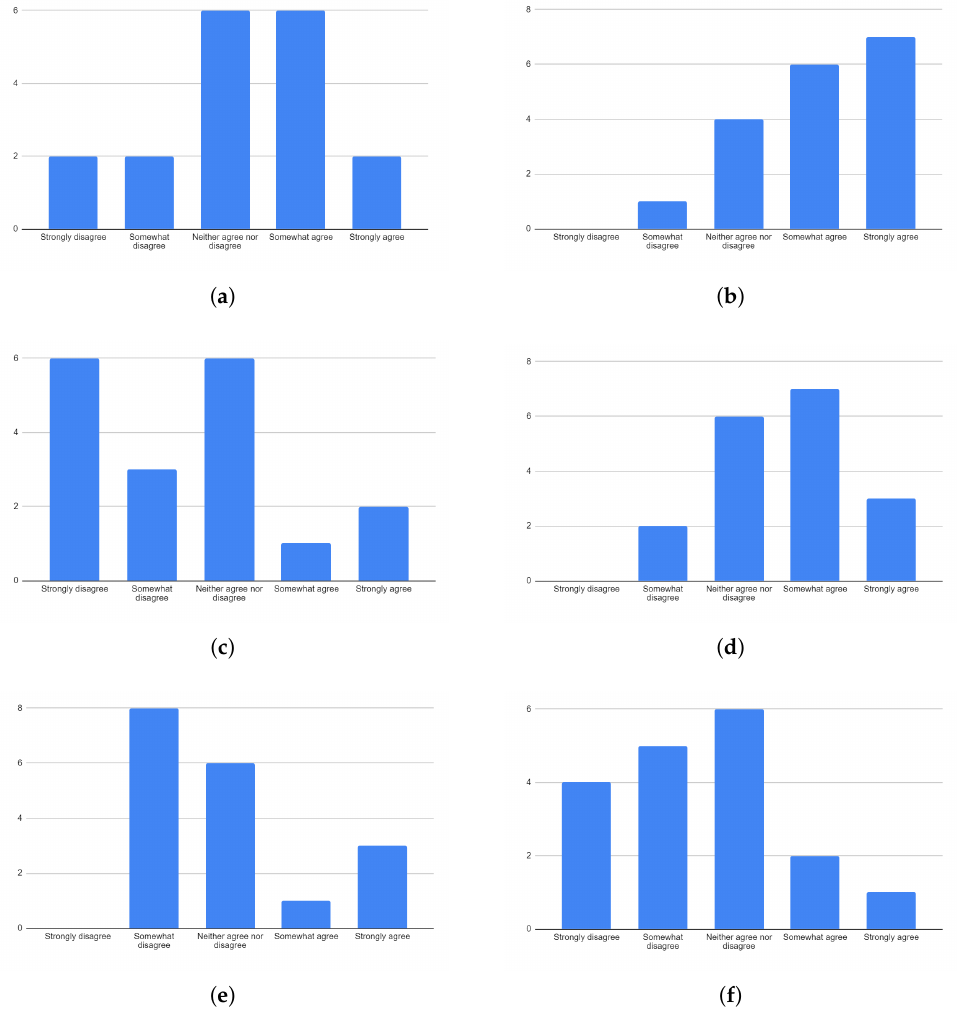
Figure 11. Histograms of questionnaire 1 responses for questions 1, 2, 7, 8 and 9. ( a ) I like studying with friends. ( b ) If I don’t understand something, I ask a friend rather than a teacher. ( c ) I like to compete with friends in solving such exercises. ( d ) I enjoy solving rhythmic dictation